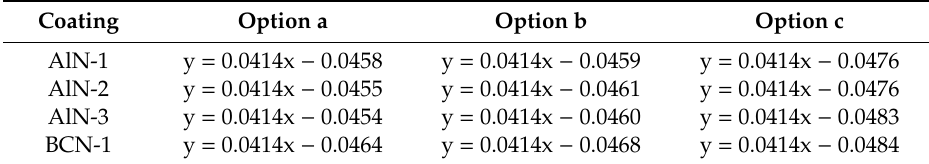
Table 3. Mathematical equation for the correlation between the thermovoltage [mV] (y) and temperature [°C] (x) of the different thin film sensor designs.